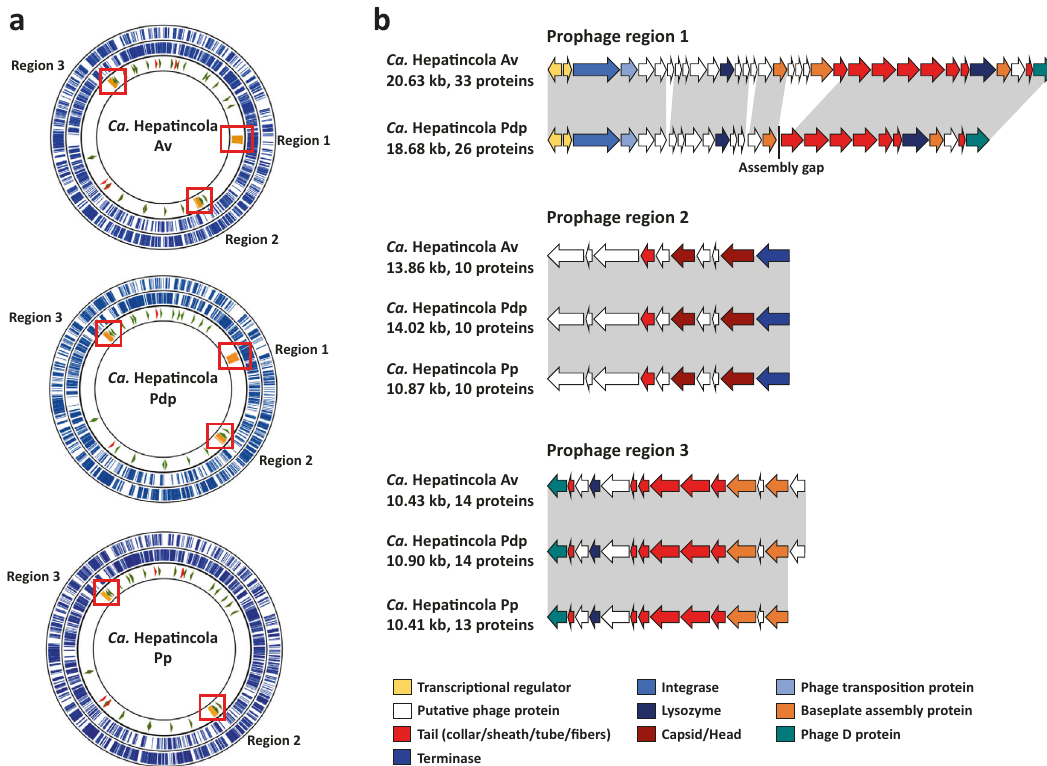
Fig. 3 Prophage regions in Hepatincola genomes. a Circular genome plots showing the positions of the three prophage regions (orange). Outer circles represent protein-coding genes on both the forward and complement strands (blue). The inner circle indicates rRNA genes (red), tRNAs (green) and prophage regions (orange). b Schematic representation of the genes within the prophage regions. Shaded areas indicate homology between the different